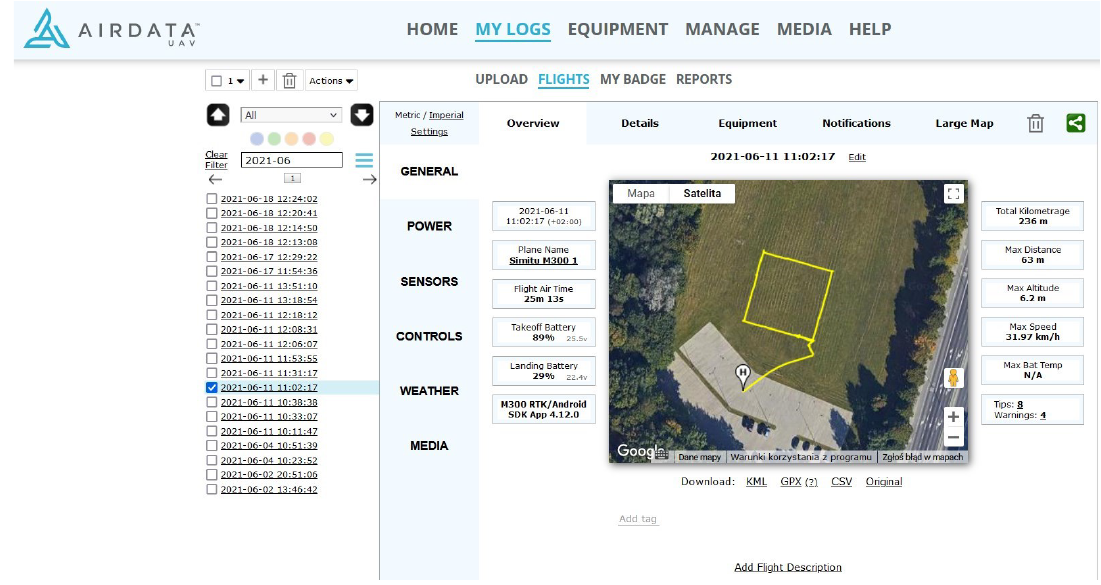
Figure 6. AIRDATA application.